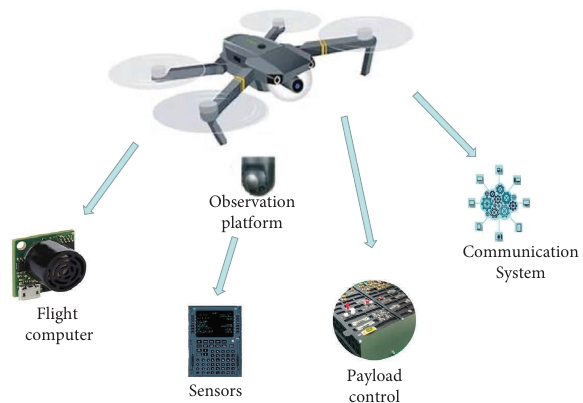
Figure 1: Structural composition of UAV remote sensing